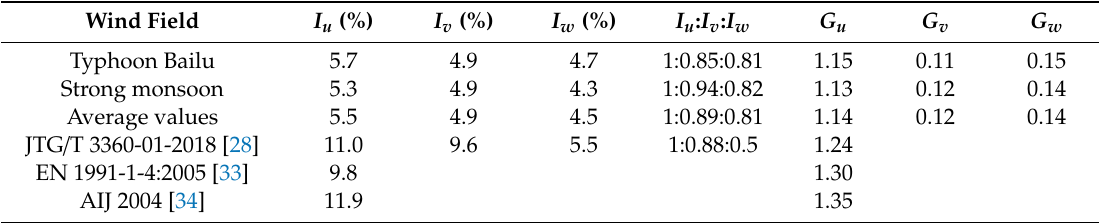
Table 1. Statistics of measured average turbulence intensities and gust factors.